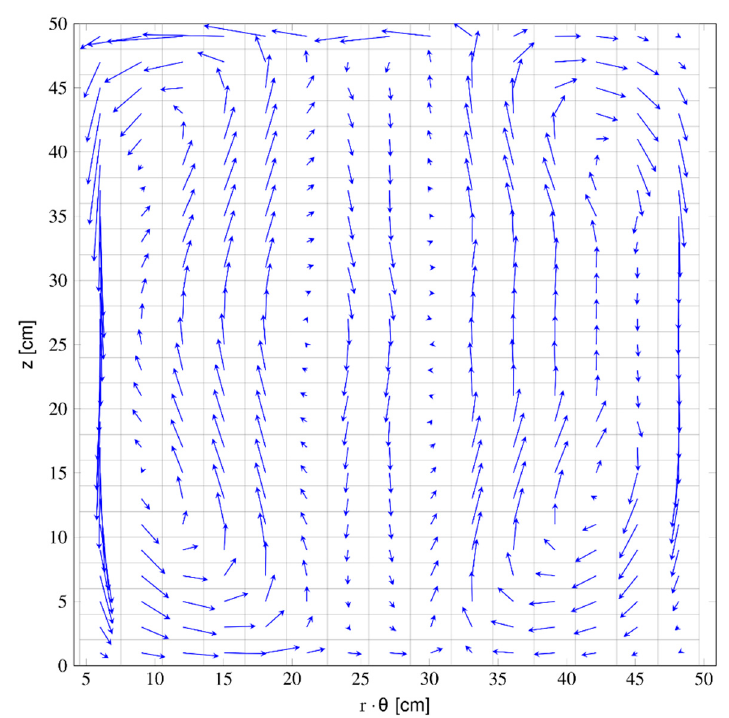
Figure 4. Eddy current distribution on the conductive compensating shield. (Reproduced with permission from [29], IEEE, 2017.)